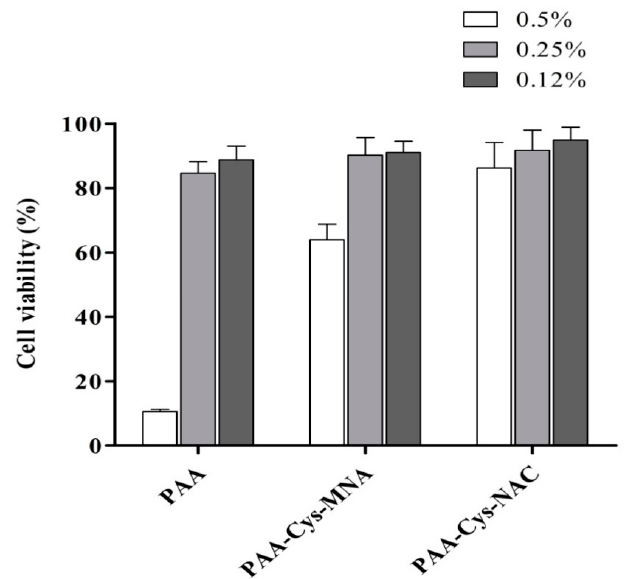
Figure 5. Cell viability of Caco-2 cells after 4 h incubation at 37 °C with PAA and S-protected thiolated PAA conjugates at indicated concentrations using resazurin assay. The data are shown as mean ± SD (n = 3).